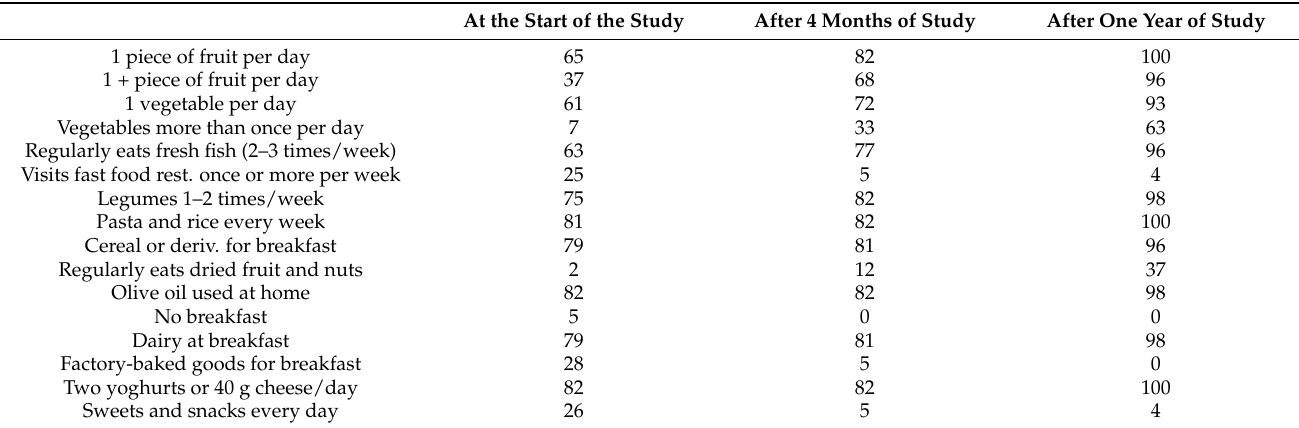
Table 7. KidMed Test (percentage).